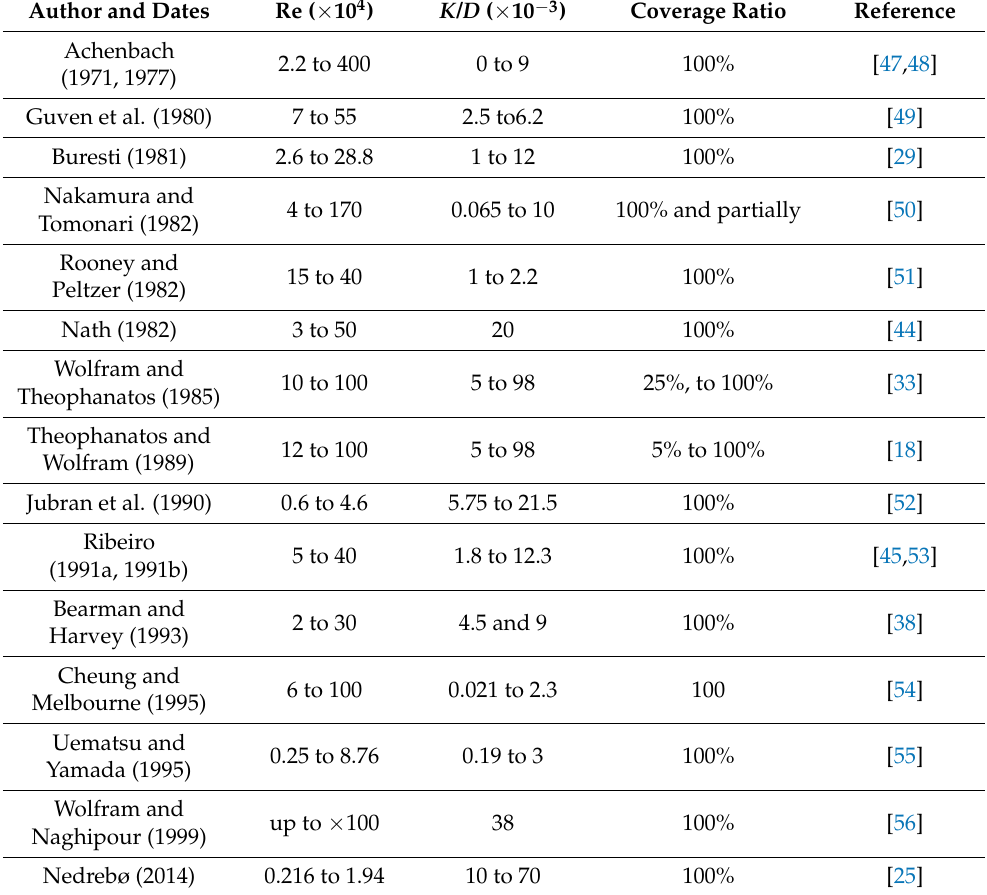
Figure 5. Variation of the mean drag coefficient with relative roughness from some researchers. Table 1. Details of some laboratory experiments on flow over a circular cylinder.